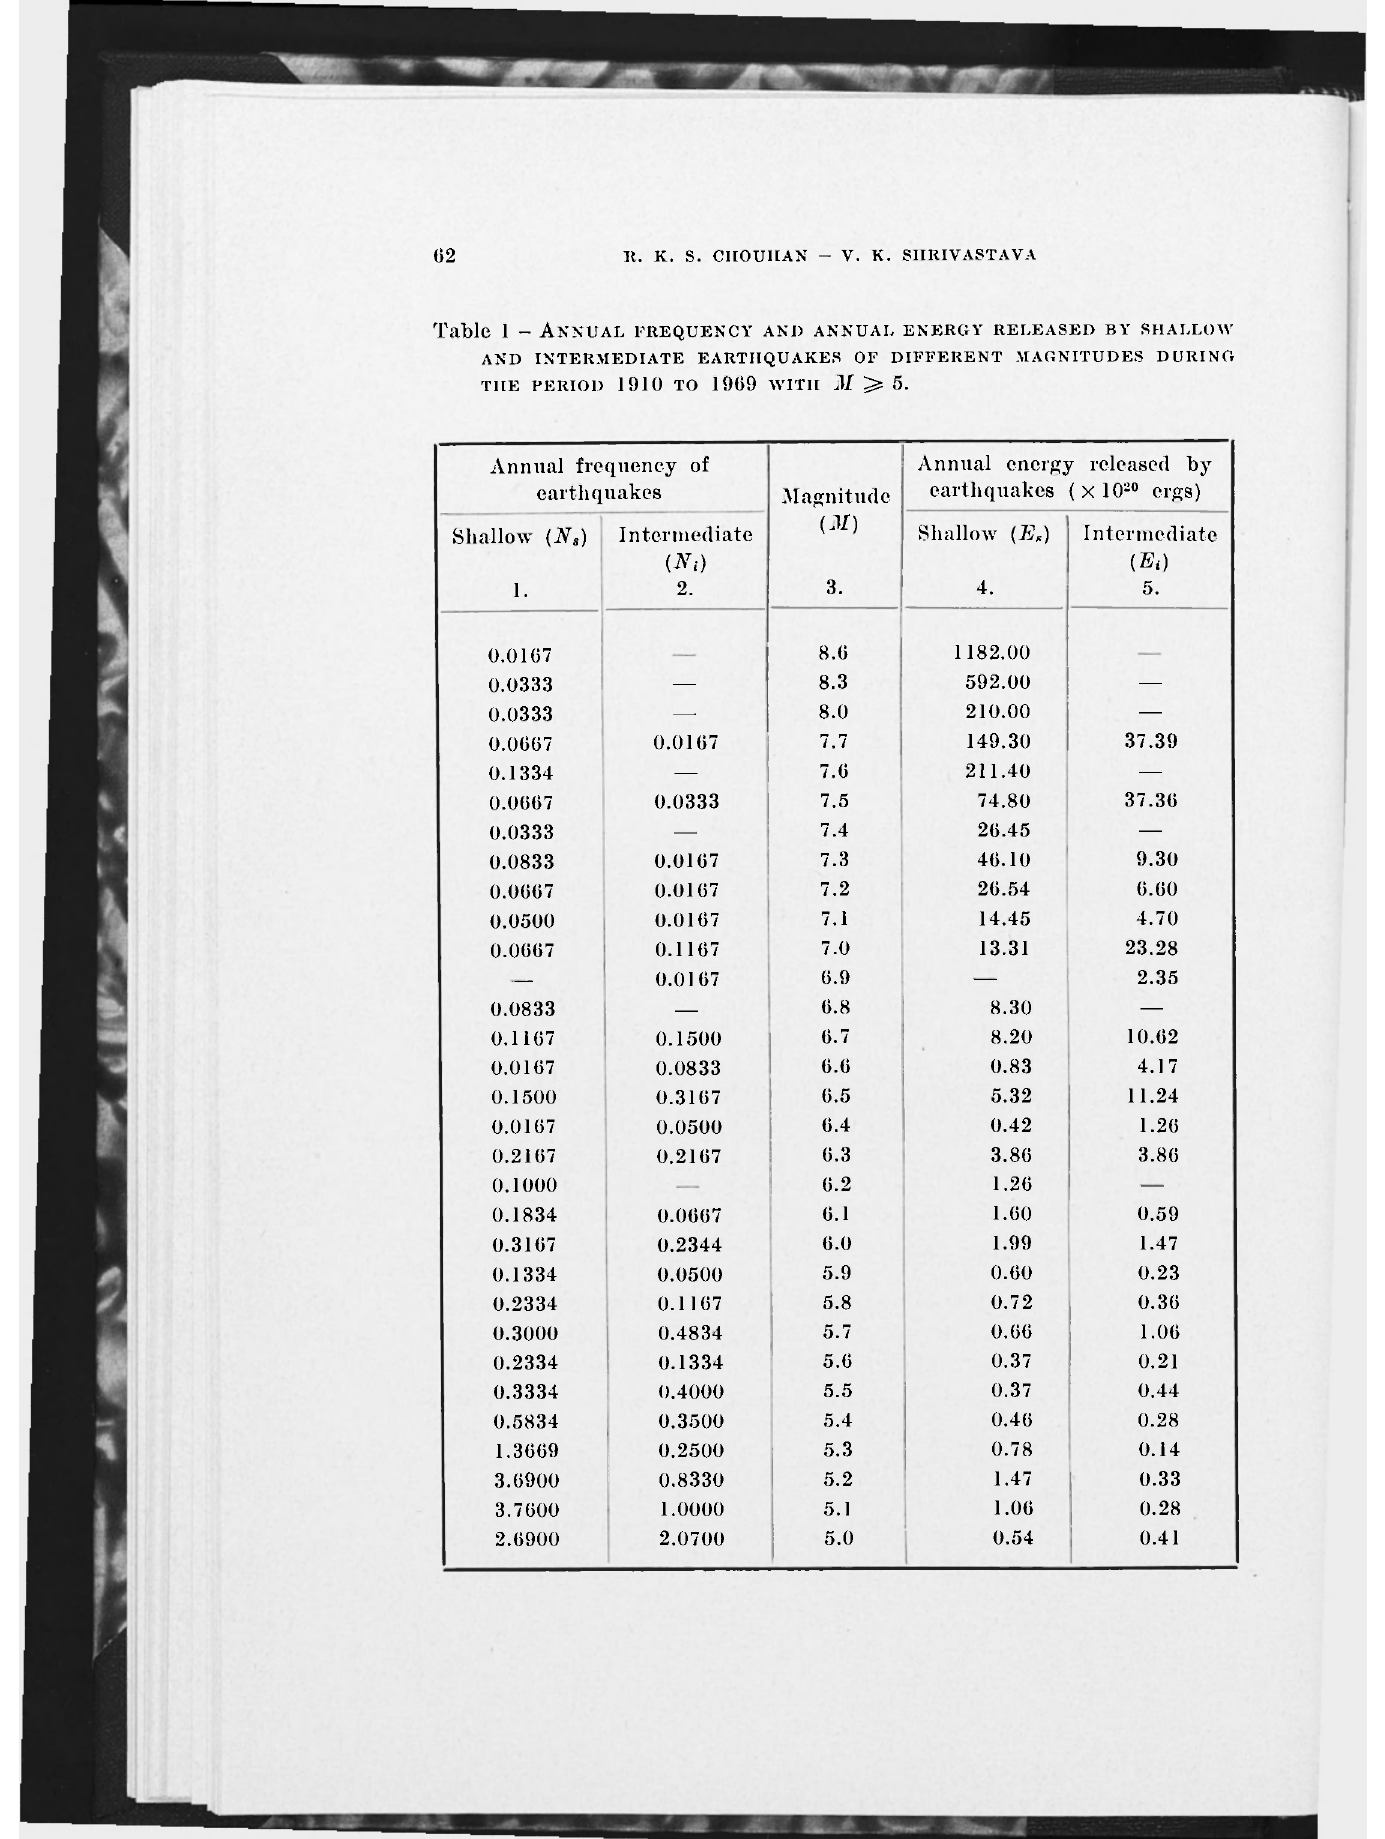
Table 1 - ANNUAL FREQUENCY AND ANNUAL ENERGY RELEASED BY SHALLOW AND INTERMEDIATE EARTHQUAKES OF DIFFERENT MAGNITUDES DURING THE PERIOD 1910 TO 1969 WITH M ^